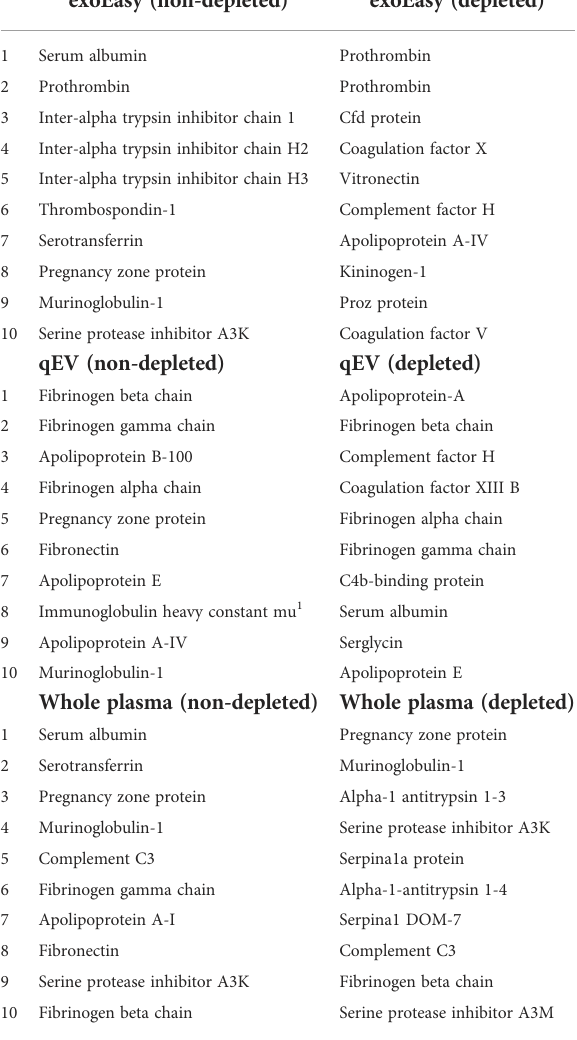
TABLE 1 Top 10 most abundant proteins detected by LC-MS/MS in whole plasma or EV enriched samples from mouse plasma by exoEasy or qEV, without (non-depleted) or after (depleted) the removal of abundant plasma proteins using the Multiple Af fi nity Removal Spin Cartridge Mouse-3